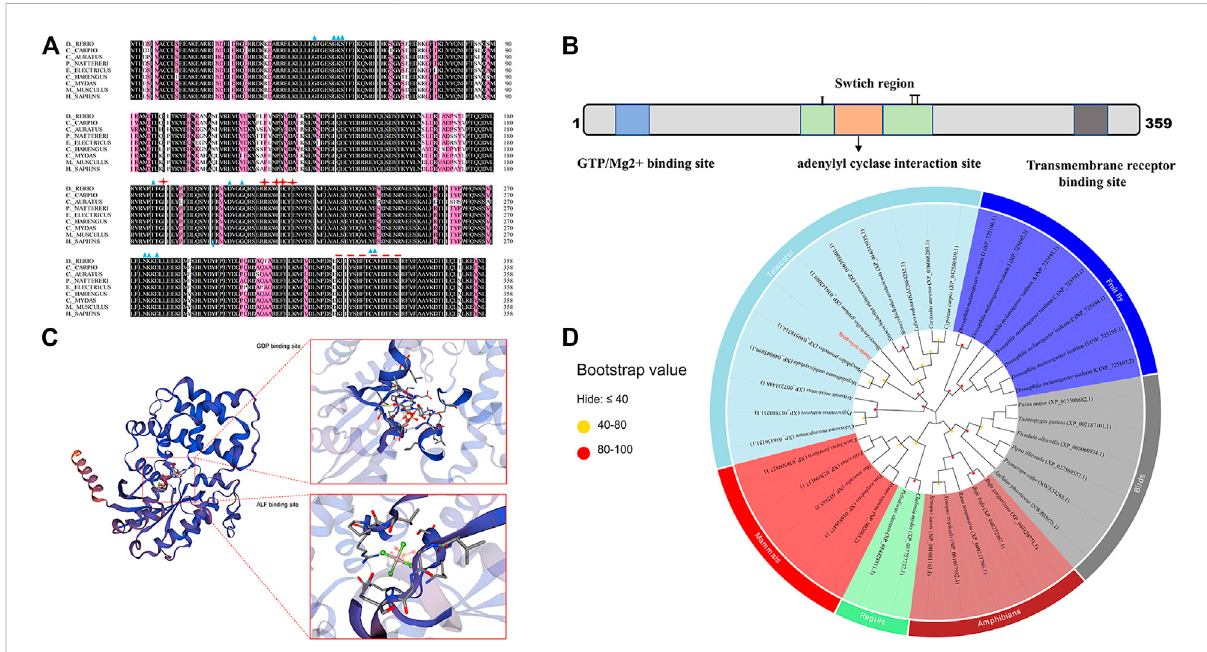
FIGURE 1 Sequence and phylogenetic analysis of gnaq . (A) Multiple sequence alignment of G α q amino acids between zebra fi sh and other species. The blue triangle indicates GTP/Mg2+ binding site, red stars represent the conserved adenylyl cyclase interaction site, and the red dotted line represents transmembrane receptor binding site. Species involved in sequence alignment: ( Cyprinus carpio , XP_042580939.1), ( Carassius auratus , enscal00000064064), ( Pygocentrus nattereri , XP_017580231.1), ( Electrophorus electricu s, XP_026881183.1), ( Clupea harengus , XP_031433518.1), ( Chelonia mydas , XP_037757737.1), ( Mus musculus , NP_032165.3), ( Homo sapiens , NP_002063.2). (B) Linear representation of G α qsequencemotifsandbindingregions. (C) Deducedtertiary-dimensionalstructureofG α q.ThestructureshowedtheGDPbindingsite(T.47,E.49, S.50, G.51, K.52, S.53, T.54, S.156, L.180, R.181, V.182, R.183, V.184, N.274, K.275, D.277, L.278, C.330, A.331, T.332) and ALF binding site (G.48, E.49, K.52, S.53, R.183, P.185, T.186, V.206, G.207, G.208, Q.209). (D) Phylogenetic tree based on the amino acid sequences of the known G α q